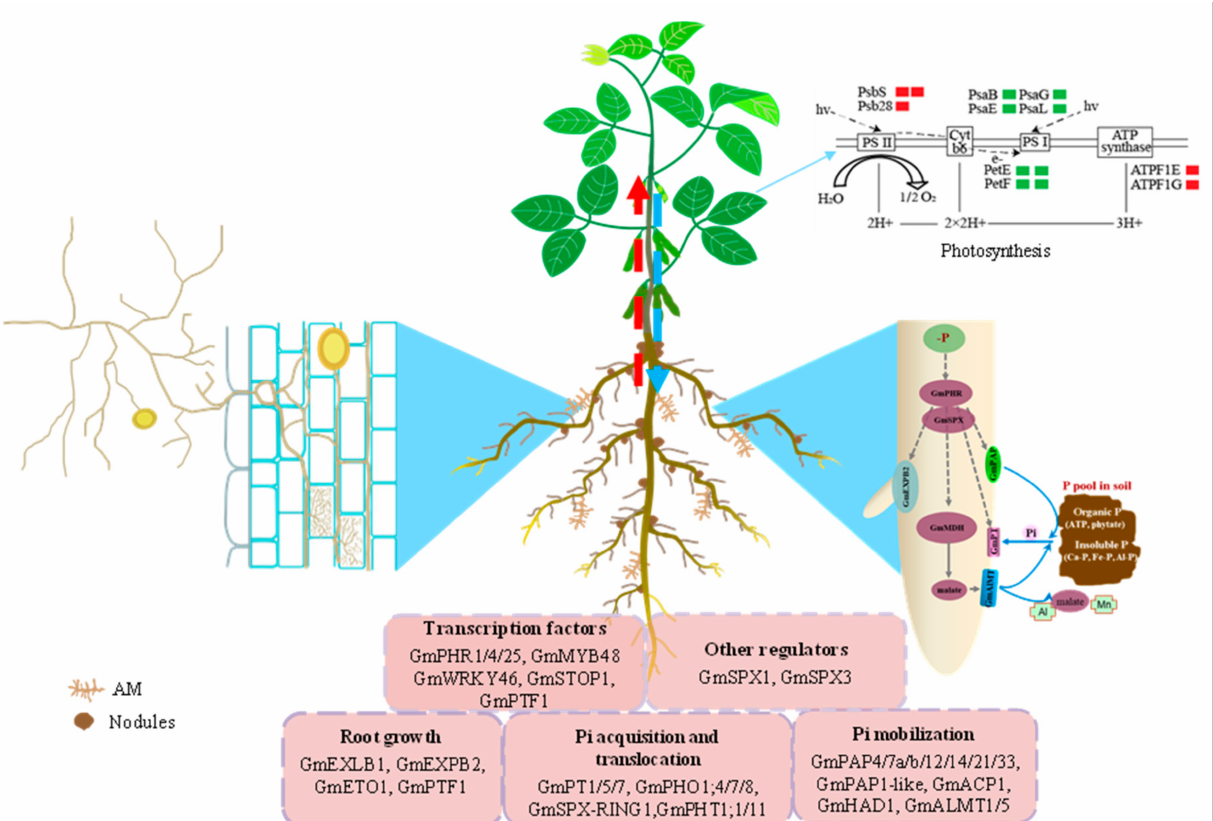
Figure 1. A model of the Pi signaling network in soybean and DAPs involved in photosynthesis. The data on DAPs involved in photosynthesis are from Cheng et al., 2021 [51]. PsbS, photosystem II 22 kDa protein; Psb28, photosystem II 13 kDa protein; PsaB, photosystem I P700 chlorophyll a apoprotein A2; PsaE, photosystem I subunit IV; PsaG, photosystem I subunit V; PsaL, photosystem I subunit XI; PetE, plastocyanin; PetF, ferredoxin; ATPF1E, F-type H + -transporting ATPase subunit eps; ATPF1G, F-type H + -transporting ATPase subunit gam; red color indicates up-regulated and green color indicates down-regulated. The number of rectangles indicates the number of DAPs. Gm, Glycine max